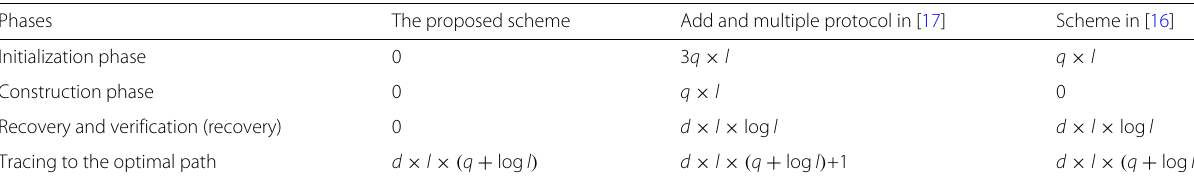
Table 3 Communication complexity